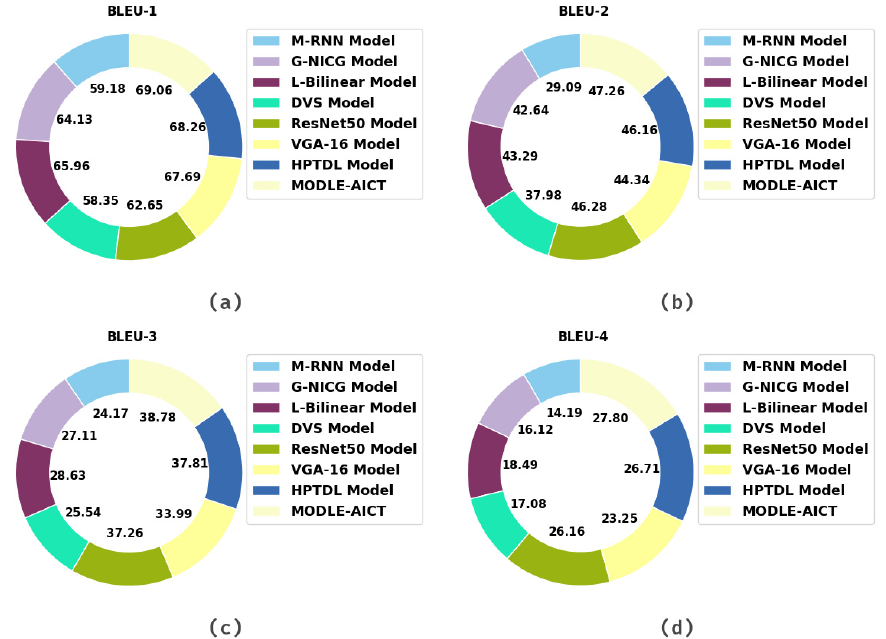
Figure 3. Result analysis of MODLE-AICT algorithm on Flickr8K dataset ( a ) BLEU-1, ( b ) BLEU-2, ( c ) BLEU-3, and ( d ) BLEU-4.